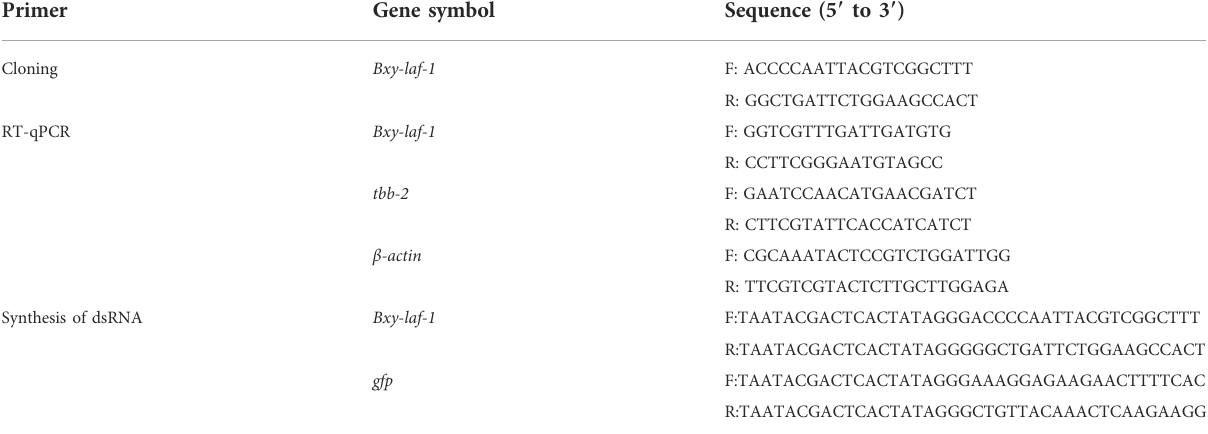
TABLE 1 Primers used in the present